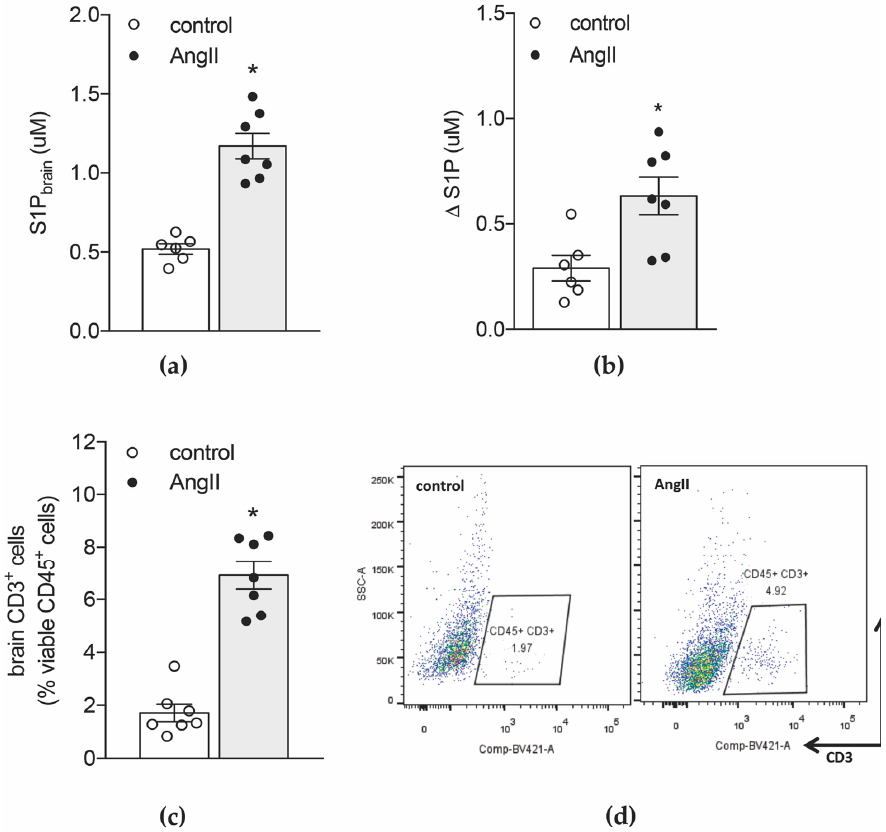
Figure 1. Hypertension links to elevated cerebral S1P levels and an accumulation of CD3+ T-cells in the brain. ( a ) Mass spectrometry analysis of S1P levels in brain tissue of normotensive and hypertensive WT mice. ( b ) Concentration difference between brain and plasma S1P levels in normotensive and hypertensive WT mice expressed as delta values ( ∆ [S1P]). ( c ) Percentage of CD3+ leukocytes in the brain of normotensive and hypertensive WT mice assessed in a FACS-based approach. ( d ) Representative dot blots showing CD45+ CD3+ cells in brain tissue of normotensive and hypertensive WT mice. Data expressed as mean ± SEM; n = 6–7 per group * p < 0.05 after single unpaired comparisons.